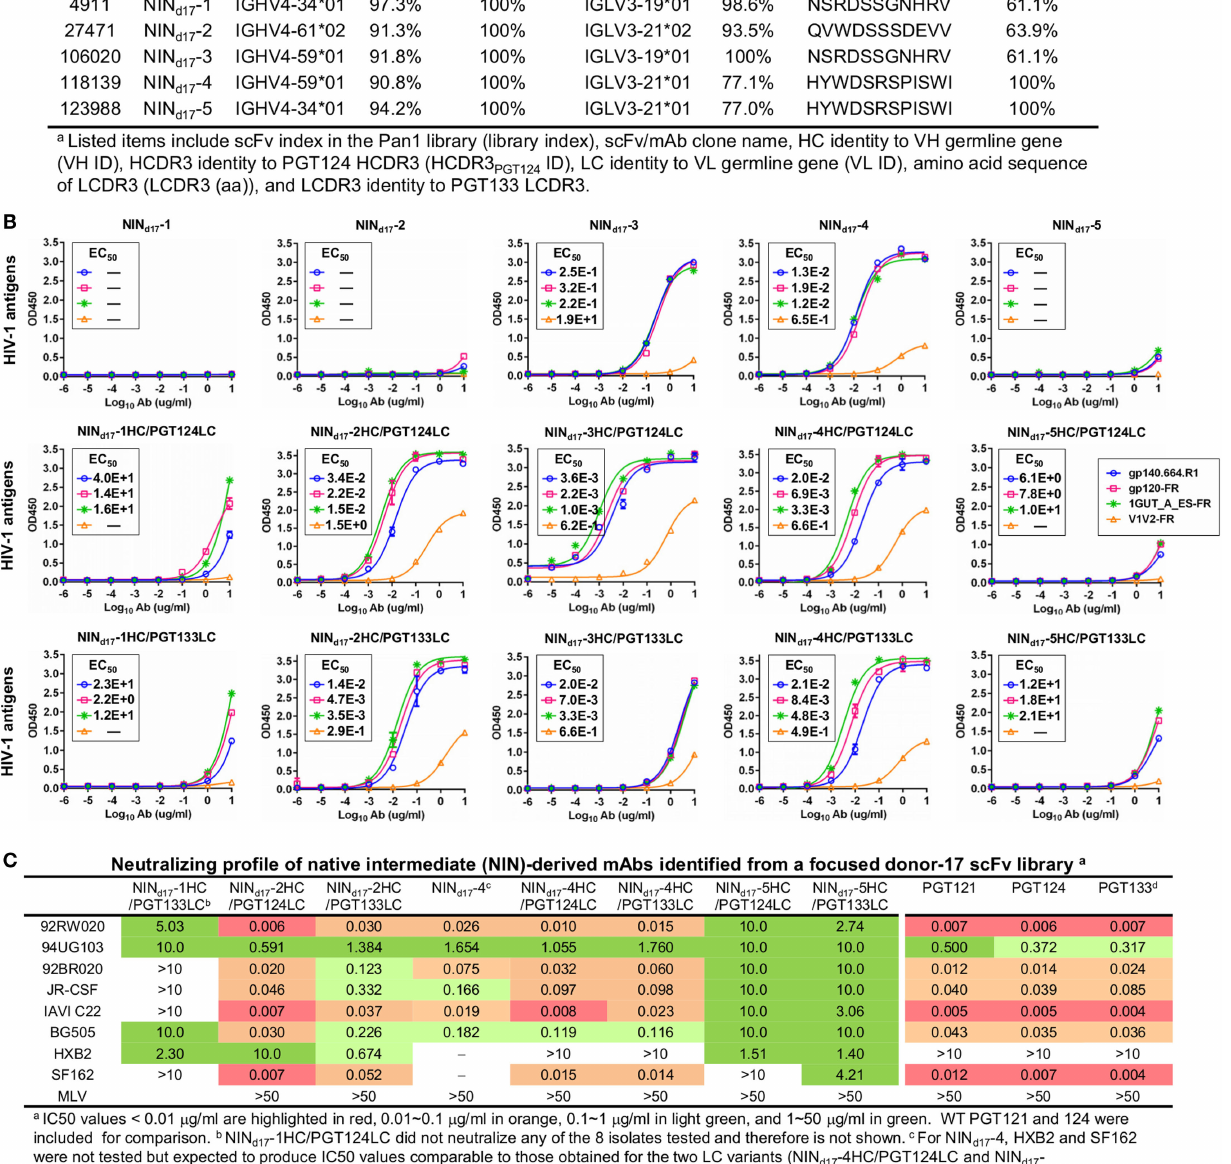
FigUre 7 | Characterization of the PGT124 intermediates identified from a focused donor-17 single-chain variable fragment (scFv) library. (a) Five native intermediates, NIN d17 -1–5, identified from the Pan1 library based on the HCDR3 analysis. (B) Enzyme-linked immunosorbent assay (ELISA) binding of NIN d17 -1–5 and their LC variants to the gp140.664.R1 trimer and three nanoparticles (gp120-FR, 1GUT_A_ES-FR, and V1V2-FR). The two sets of LC variants were derived by pairing the NIN HCs with PGT124 and PGT133 LCs. EC 50 values are labeled for all ELISA plots except for instances in which the highest OD 450 value is below 0.1 or in the cases of ambiguous data fitting. (c) Neutralization profiles of selected NIN d17 variants against six tier-2 viruses and two tier-1 viruses, with WT broadly neutralizing antibodies PGT121, 124, and 133 included as references. IC 50 values are highlighted based on the same color-coding scheme as in Figure 4c